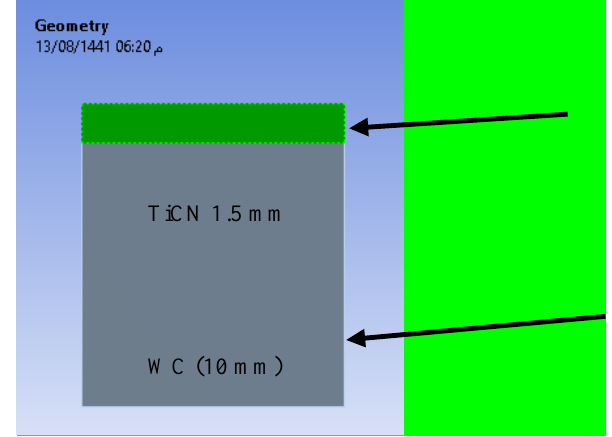
Fig. 16. Adding layer of TiCN, 1.5 mm in cemented carbide